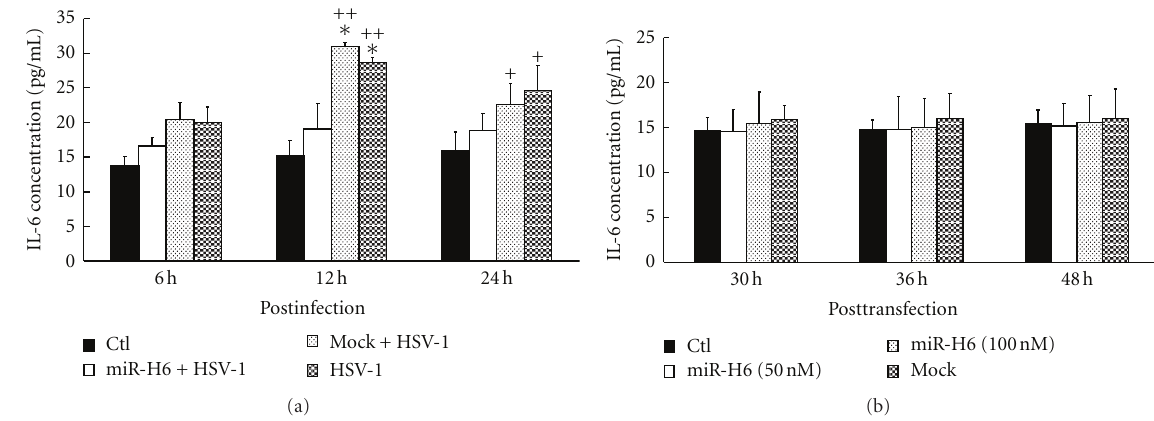
Figure 3: The e ff ect of miR-H6 on IL-6 release in medium. HCE cells were transfected with miR-H6 and infected with MOI 0.1 of HSV- 1 after 24h posttransfection (a) or without viral infection (b). The IL-6 level in medium was measured at indicated time p.i. by ELISA. ∗ Statistical di ff erence between HCE cells transfected with miR-H6 mimics and mock or HSV-1 alone ( P < 0 . 01); + / ++ statistical di ff erence between normal HCE cells and mock or HSV-1 alone ( + P < 0 . 05; ++ P < 0 .